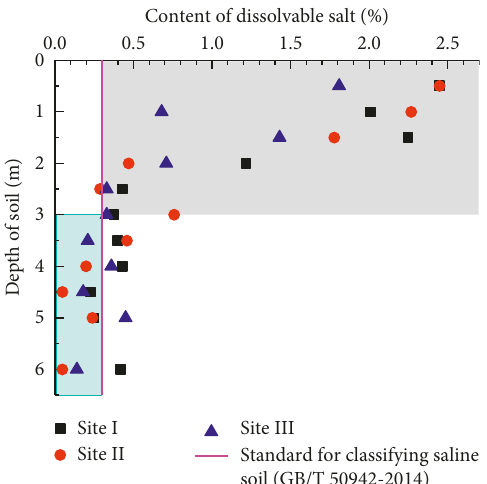
Figure 2: Variation of dissolved salt content with depth.